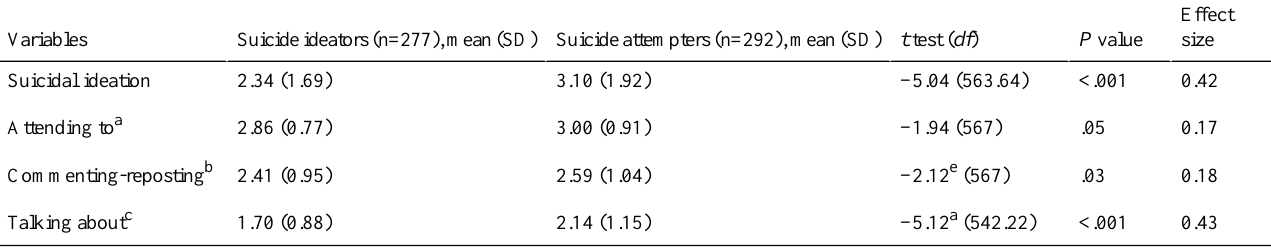
Table 3. Group differences on study variables by suicidal status